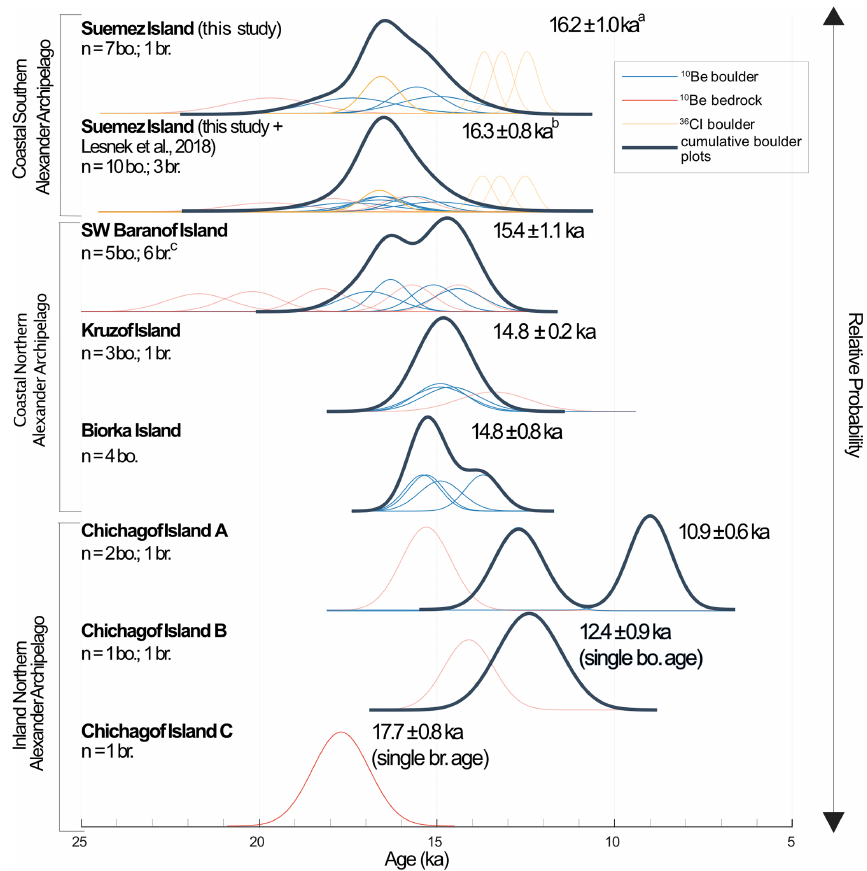
Figure 9. Relative probably plots of bedrock (red) and boulder (blue) 10 Be and 36 Cl boulder (yellow) ages from this study calculated with 1 σ internal uncertainty. bo. – boulder, br. – bedrock. All ages shown are mean ages from only boulders at each sample site reported with 1 SD unless noted. Cumulative plots represent all bold lines – transparent lines were not included in their calculation. a Average of all 10 Be boulder ages and oldest 36 Cl boulder age with 1 SD. b Average of all 10 Be boulder ages (this study and Lesnek et al., 2018) and oldest 36 Cl boulder age (this study). c One old outlier at 28.0 ± 1.1ka not